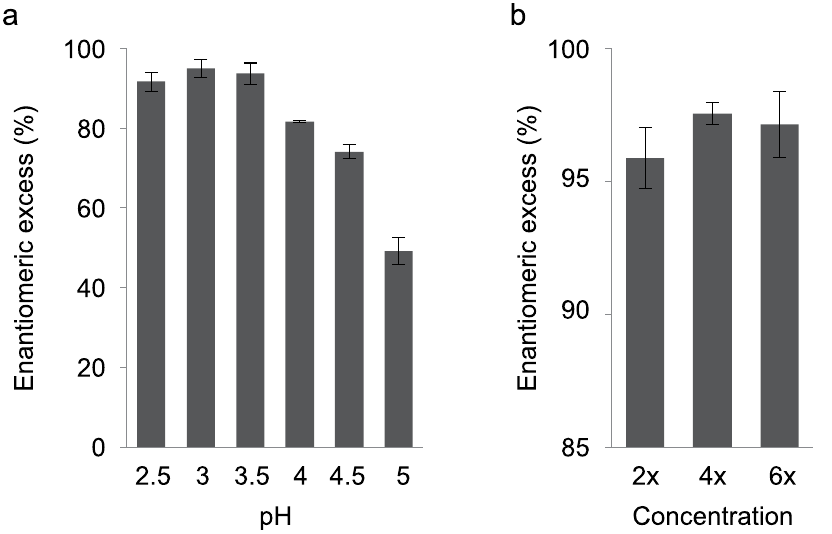
Figure 5. Synthesis of ( R )-mandelonitrile using E. coli cells expressing Pton3HNL in aqueous solution. ( a ) Relationship between pH and enantiomeric excess (ee). E. coli cells harvested from 0.4 mL culture were reacted in 0.2 mL 300 mM sodium citrate buffer (pH 2.5–5.0) containing 50 mM benzaldehyde and 100 mM KCN at 22 °C for 5 min. ( b ) Relationship between cell amounts and ee. E. coli cells harvested from 0.4 (2 × ), 0.8 (4 × ), or 1.2 mL (6 × ) were reacted in 0.2 mL 0.3 M sodium citrate buffer, pH 3.0, containing 50 mM benzaldehyde and 100 mM KCN at 22 °C for 5